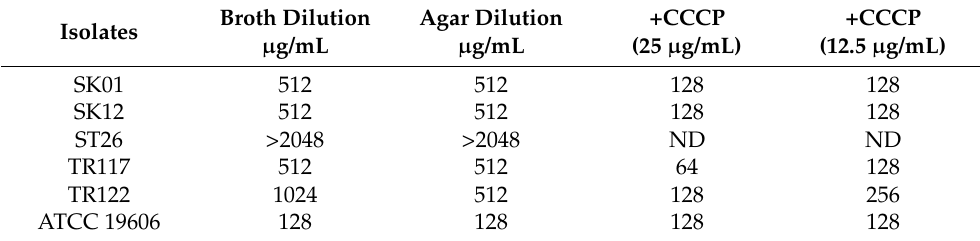
Table 1. Minimum inhibitory concentrations of fosfomycin against carbapenem- and fosfomycin- resistant Acinetobacter baumannii isolates evaluated using the agar dilution method and broth microdi- lution with and without carbonyl cyanide 3-chlorophenyl hydrazine (CCCP). Isolates